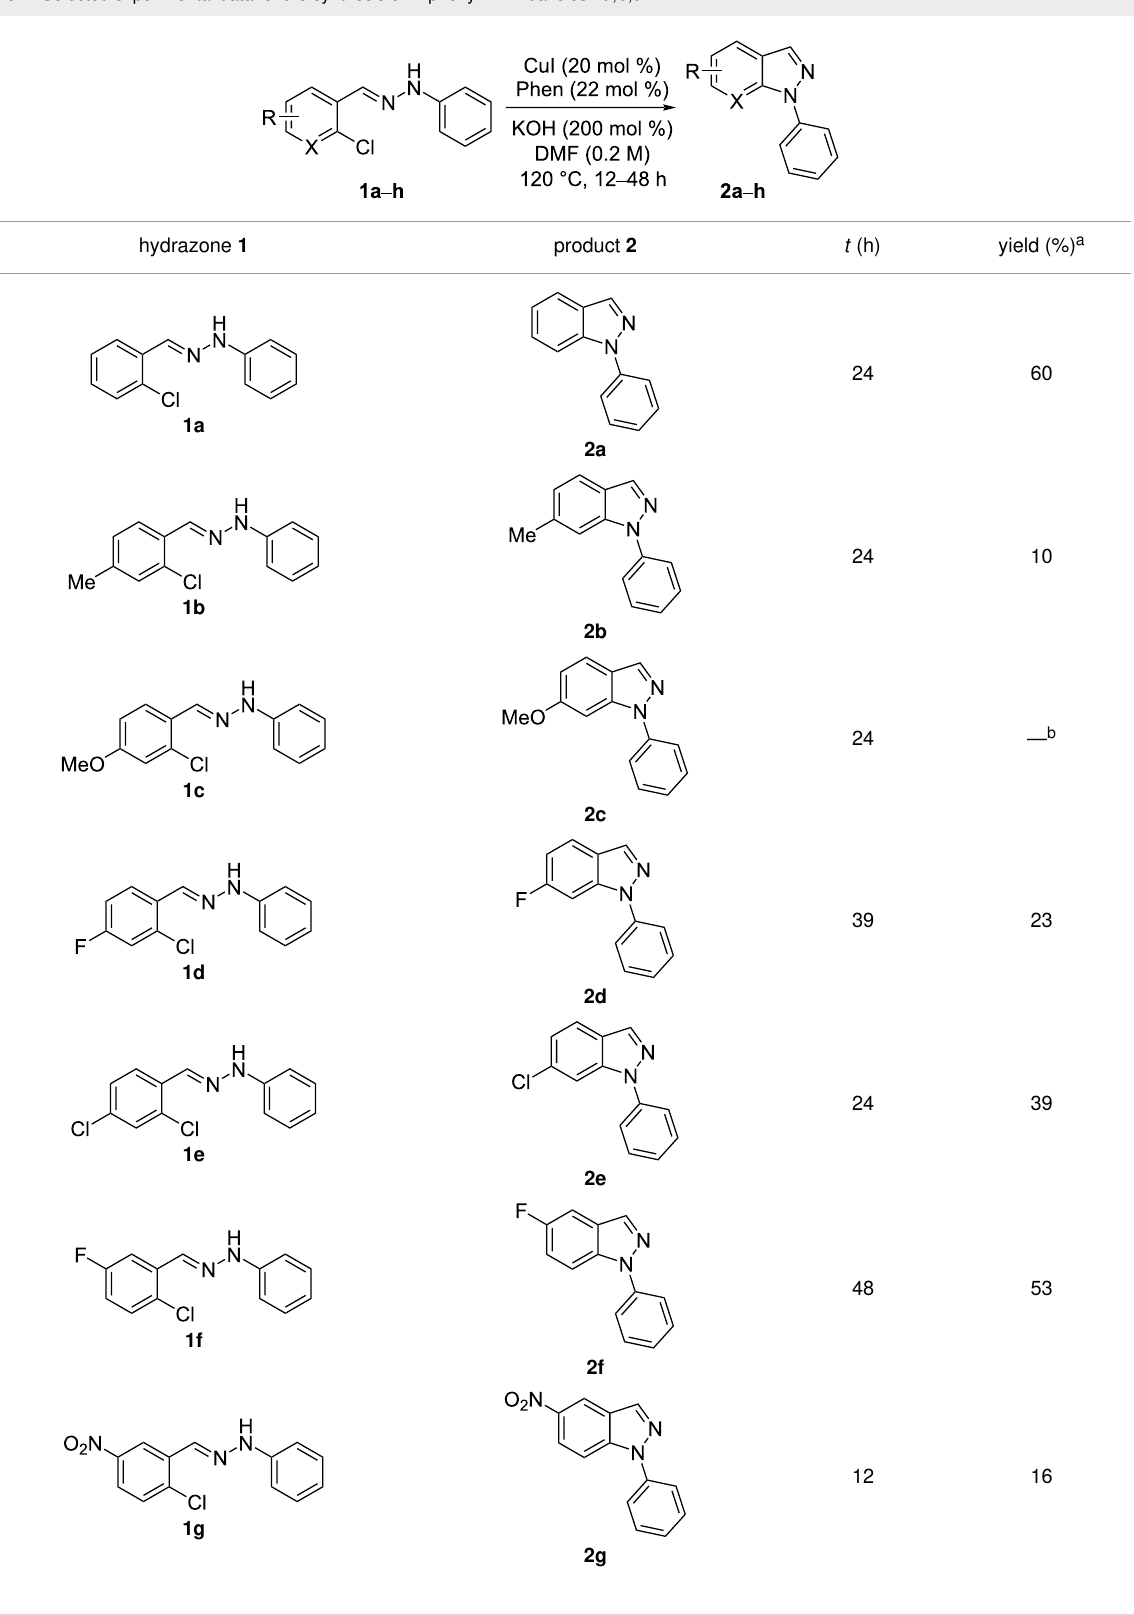
Table 2: Selected experimental data for the synthesis of N -phenyl-1 H -indazoles 2a , b , d – h